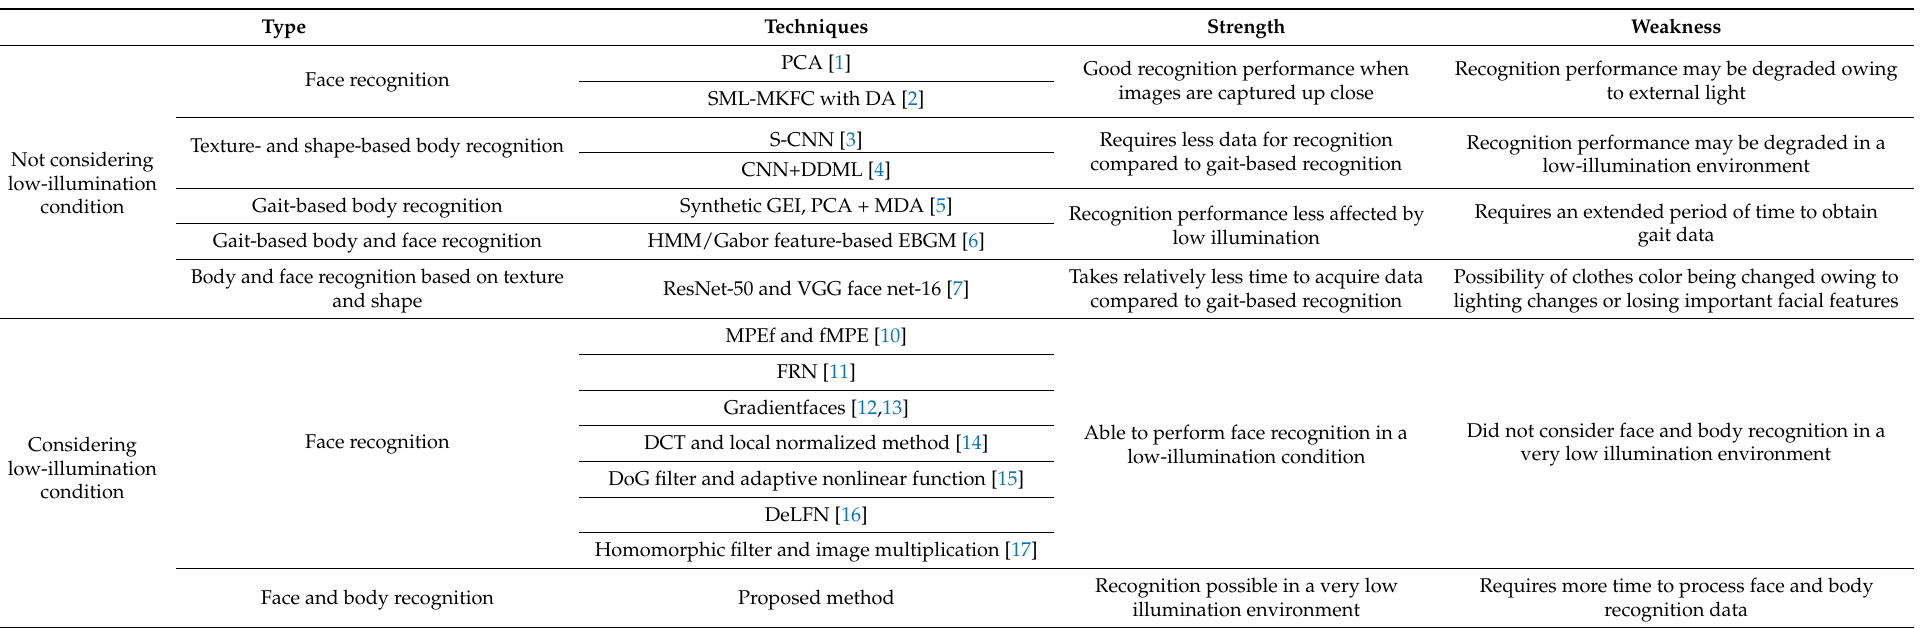
Table 1. Overview of the previous studies and the proposed method about low-illumination multimodal human